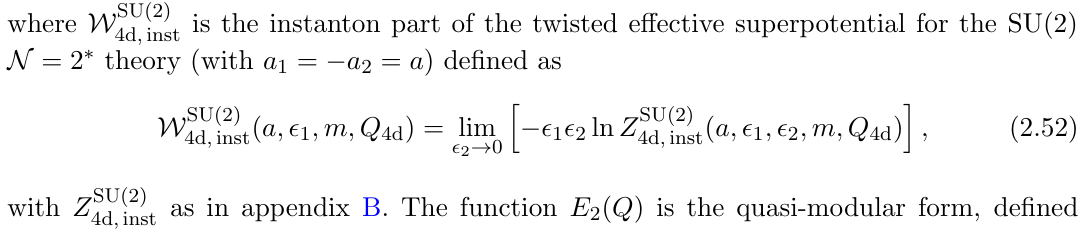
Table 3 . Energies for the 2-eCM B model at g x =